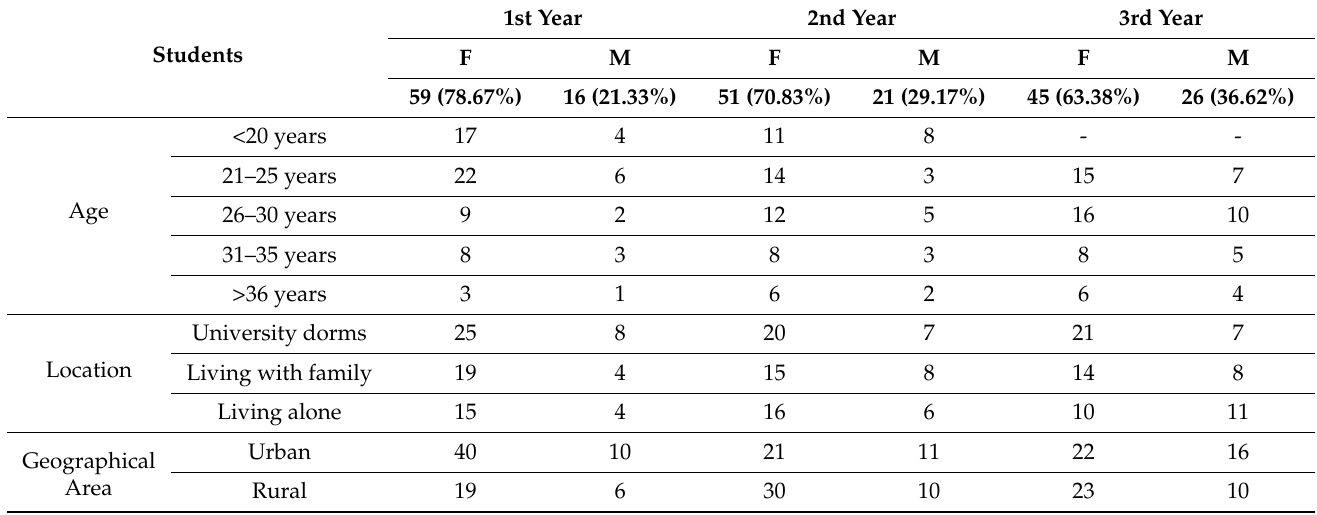
Table 1. Socio-demographic characteristics of the study group.